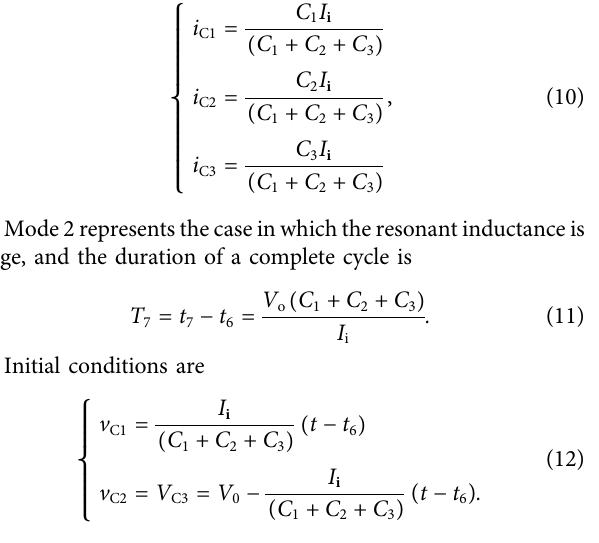
Frontiers in Energy Research |